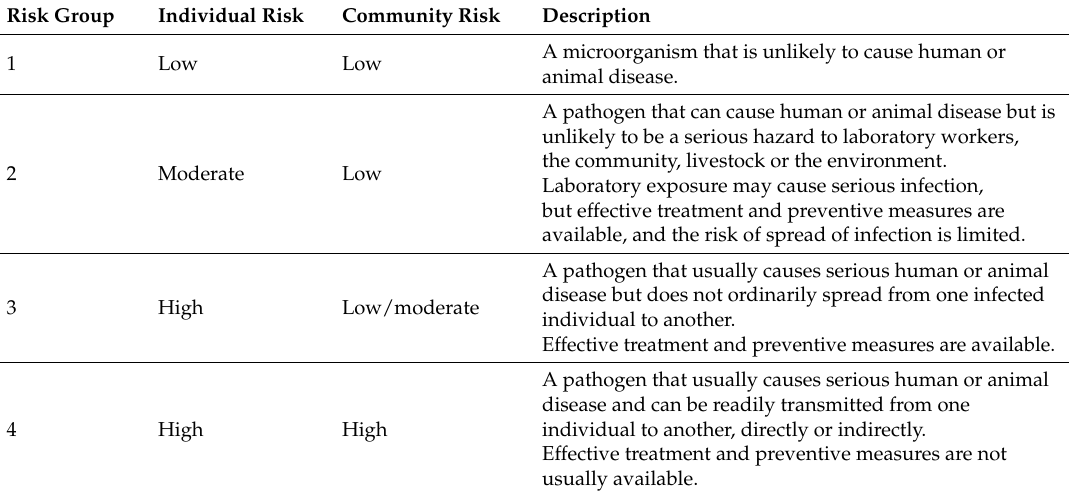
Table 2. WHO and NIH risk group classifications. Reproduced from WHO